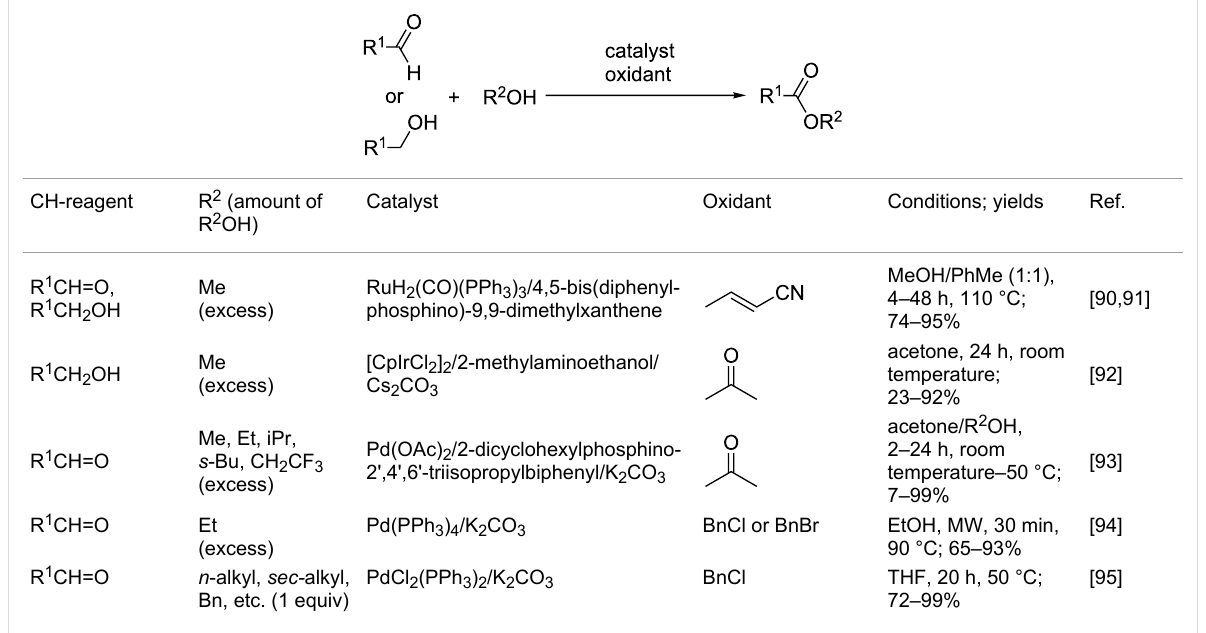
CH-reagent R 2 (amount of R 2 OH)